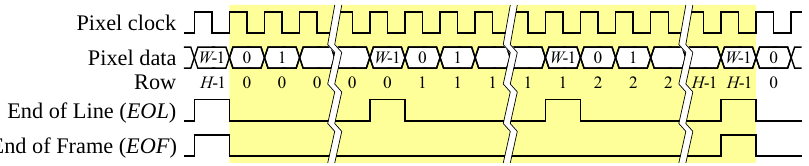
Figure 2. Continuous pixel stream, and associated control signals. The stream for one frame is highlighted.